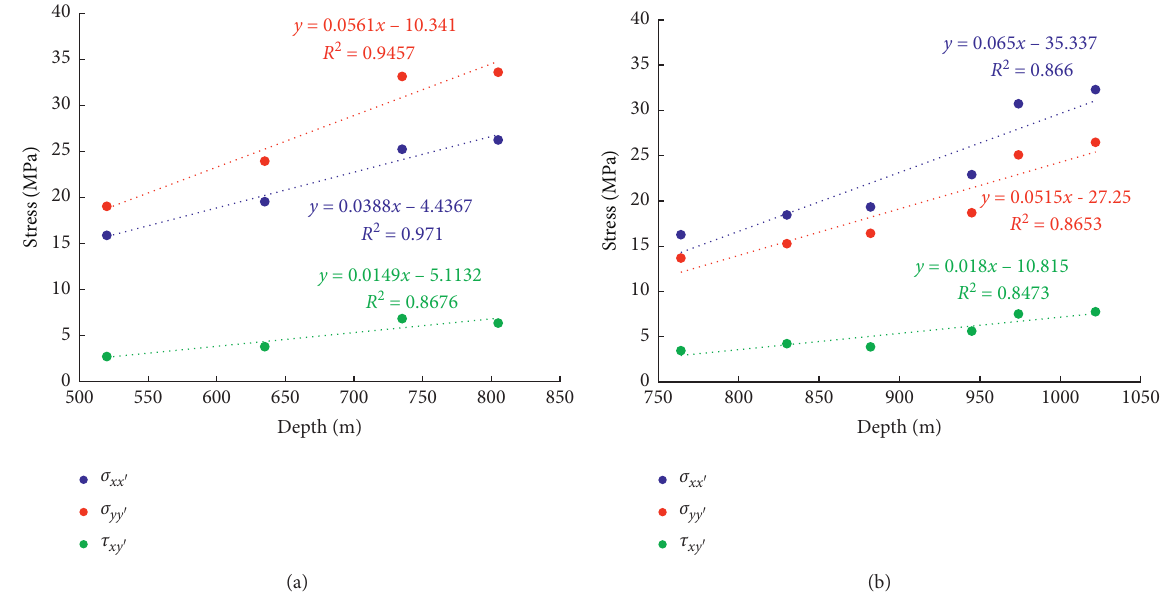
Figure 7: Variation of borehole stress components with buried depth in model coordinates. (a) ZK1. (b)